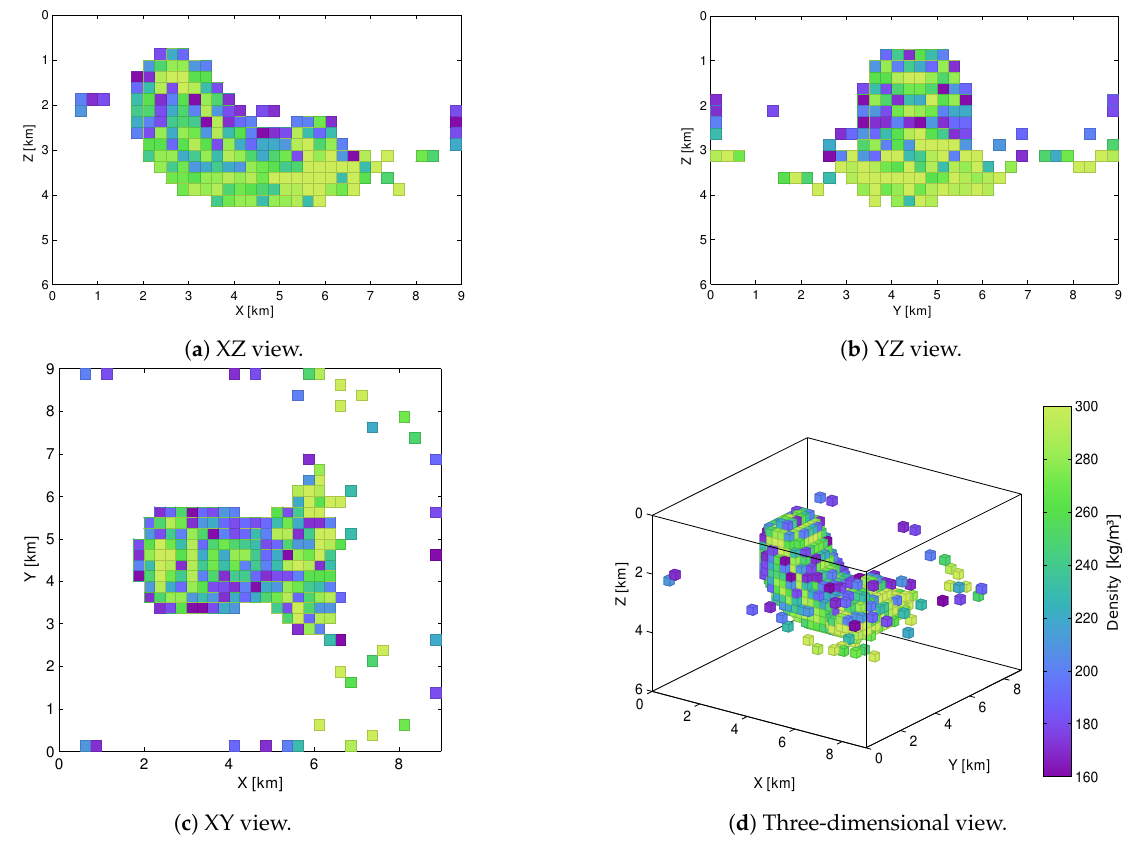
Figure 20. Inverted gravimetric S model.